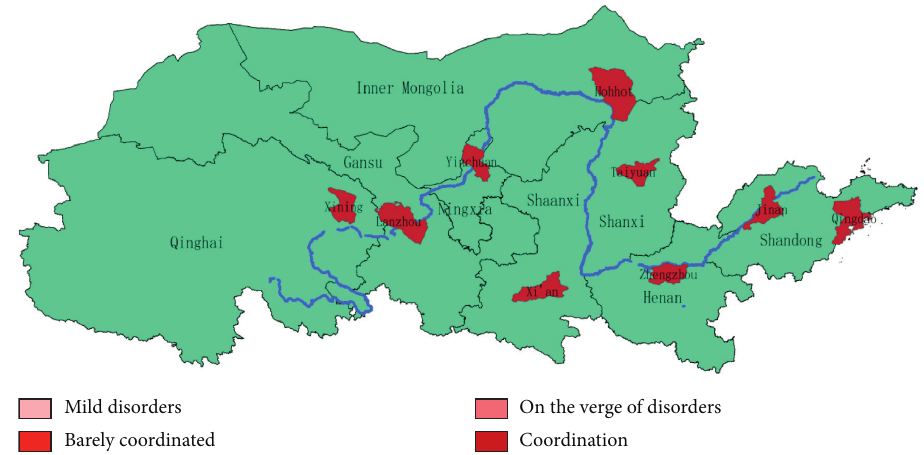
Figure 8: Coupling coordination level of central cities in the Yellow River Basin in